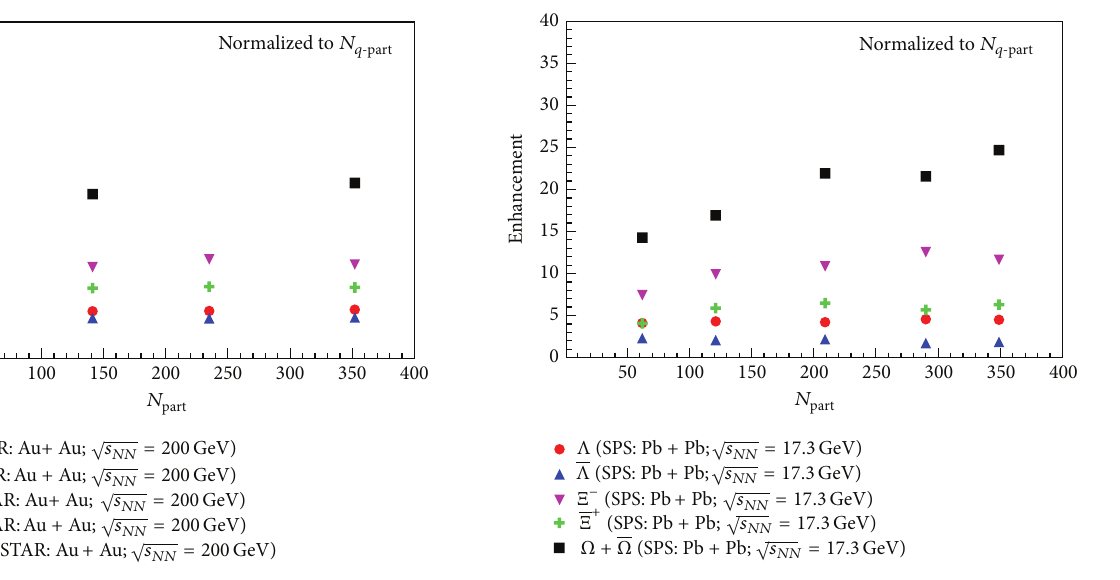
Figure 9: Midrapidity 𝑁 𝑞 -normalized enhancement of multi- -part strange baryons as a function of centrality for Au + Au collisions at √𝑠 𝑁𝑁 = 200 GeV at RHIC.